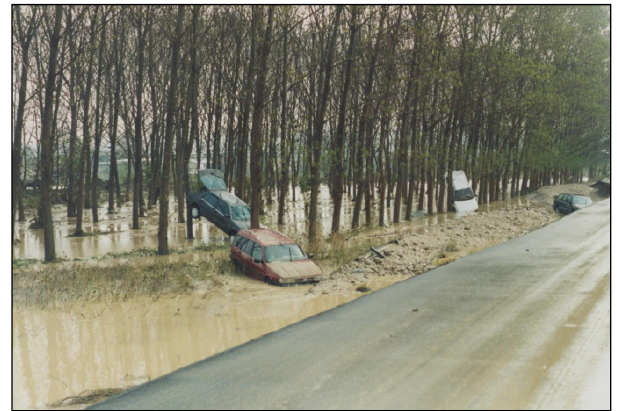
Fig. 13 – Tanaro floodwaters swept away cars on the Asti-Cuneo link road, causing two deaths (Y in Fig. 2).